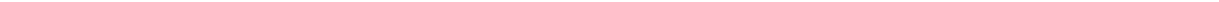
Fig. 5 Quantitative prediction for mRNA noise dependence on mRNA lifetime fl uctuation. a Models of the mRNA degradation process: (left) the Michaelis – Menten sub-Poisson process; (middle) one-state Poisson process; (right) two-state super-Poisson process. mRNA degradation starts from state 1. The three models represent renewal processes with different distributions of mRNA degradation time. Randomness, R d , in mRNA degradation time or lifetime is de fi ned by the relative variance of mRNA lifetime minus unity. For sub-Poisson mRNA degradation, R d < 0; for a Poisson process, R d = 0; and for a super-Poisson process, R d > 0. b mRNA lifetime distributions. (red line) Michaelis – Menten (MM) sub-Poisson process; (green) 1-state Poisson process; (blue line) 2-state super-Poisson process (Supplementary Note 16). The 2-state super-Poisson model has been used to model the bi-exponential lifetime distribution of atoS , fabB , and ykgE mRNA 63 – 65 . The mean mRNA lifetime is set equal to 25.8 s, the mean lifetime of atoS mRNA. c , d Time dependence of the mean and Fano factor in the number of mRNA transcribed by a single gene. The mean and Fano factor of mRNA number are calculated from equation (M1-6) and Eq. (1) for Model III, optimized from our analysis in Fig. 2 for experimental data obtained from slowly growing E. coli 36 (see Supplementary Table 1). The fraction of the active gene state is set to 1/2. e , f Dependence of the steady-state non-Poisson mRNA noise on the mean and randomness of the mRNA lifetime for two models: for the two-state super-Poisson mRNA degradation model without cell-to-cell heterogeneity ( e ) and for the 1-state Poisson mRNA degradation model, but with cell-to-cell heterogeneity in the rate ( f ). The theoretical prediction is made by the CFT in e , but by the generalized CFT, equation (M8-5) in f . (surface) Theoretical prediction. (spheres) Simulation results. (cubes) Prediction for atoS , fabB , and ykgE mRNA transcribed under IPTG inducible lac promoter in slowly growing E. coli shown in Fig. 2, given the 2-state super-Poisson model of mRNA degradation is (cid:6) (cid:7) valid 66 . Non-Poisson mRNA noise is measured by Δ x ð Þ (cid:4) Q n = n h i Q n = n h i , or the mean mRNA number dependent component of non-Poisson mRNA 1 (cid:2) 1 j x ¼ 1 noise produced by single-gene transcription (see Supplementary Note 6). Both models yield the same bi-exponential mRNA lifetime distribution. mRNA noise increases with the randomness in the mRNA lifetime originating from cell-to-cell heterogeneity in the mRNA degradation rate, but decreases with an increase in the randomness of mRNA lifetime caused by non-Poisson mRNA degradation dynamics (Supplementary Note 4 and Supplementary Movies 1 and